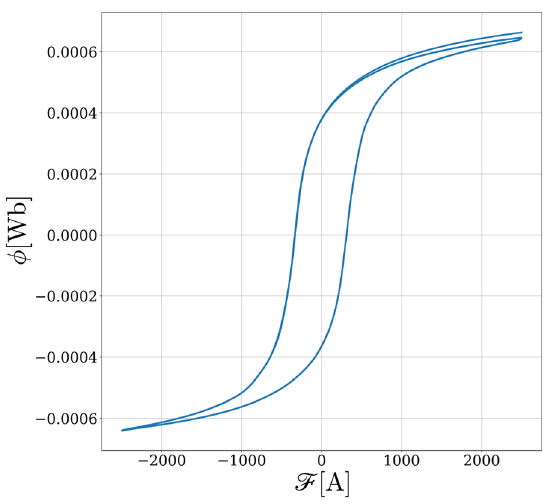
Fig. 17 Hysteresis characteristics of reluctance R visited during the WD